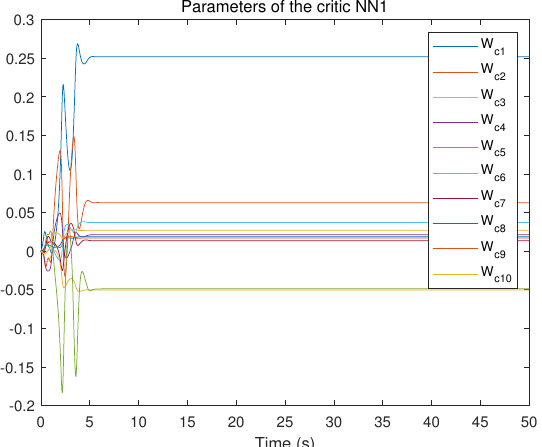
Figure 3. Convergence curves of the critic NN1 weights for player 1.